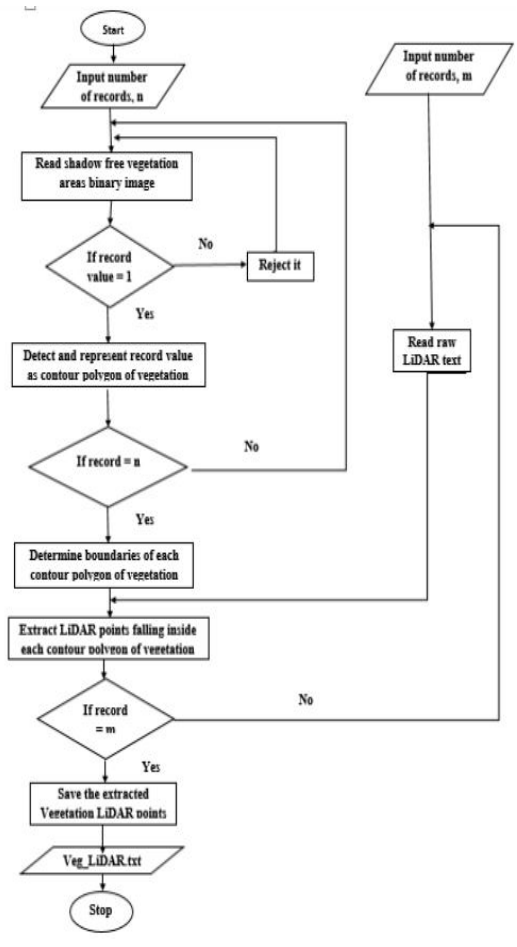
Figure 6: Pseudo code flow chart of extracting 3D information about vegetation from the integrated datasets